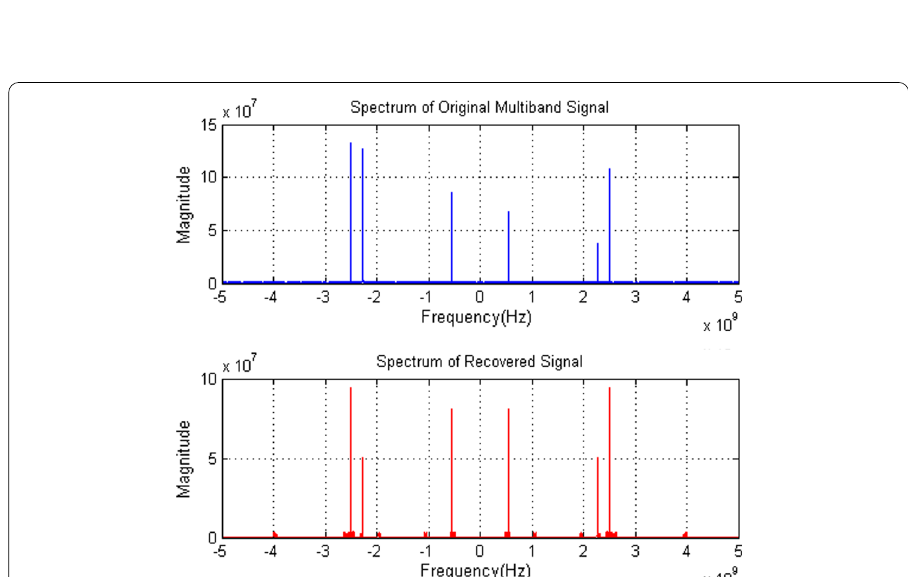
Fig. 6 Spectrum comparison diagram of signal reconstruction in